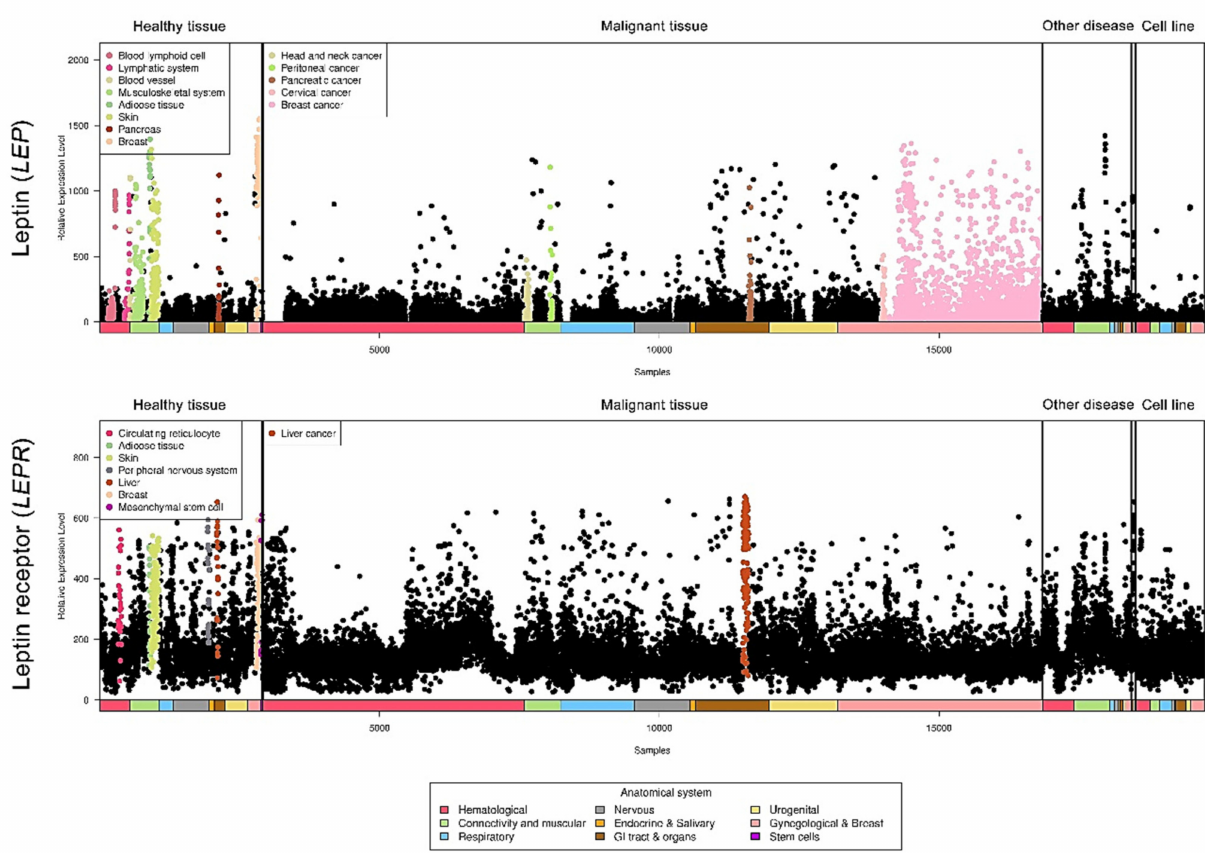
Figure 3. LEP and LEPR expression in a pancancer panel. In a pancancer dataset, LEP and LEPR expression levels were presented separately in various cancer types. The colored dots represent individual patients with higher expression of the indicated molecule among all cancer types. The raw data were retrieved from the online IST